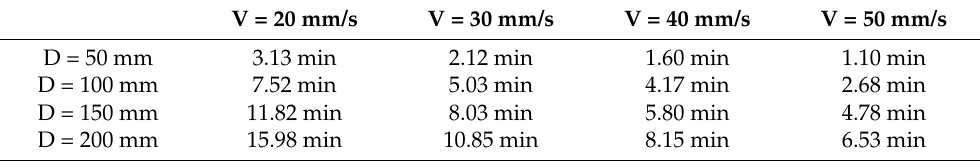
Figure 11. Photos of some of the printed hollow cylinders. Table 4. The printing times for each sample according to its diameter and printing